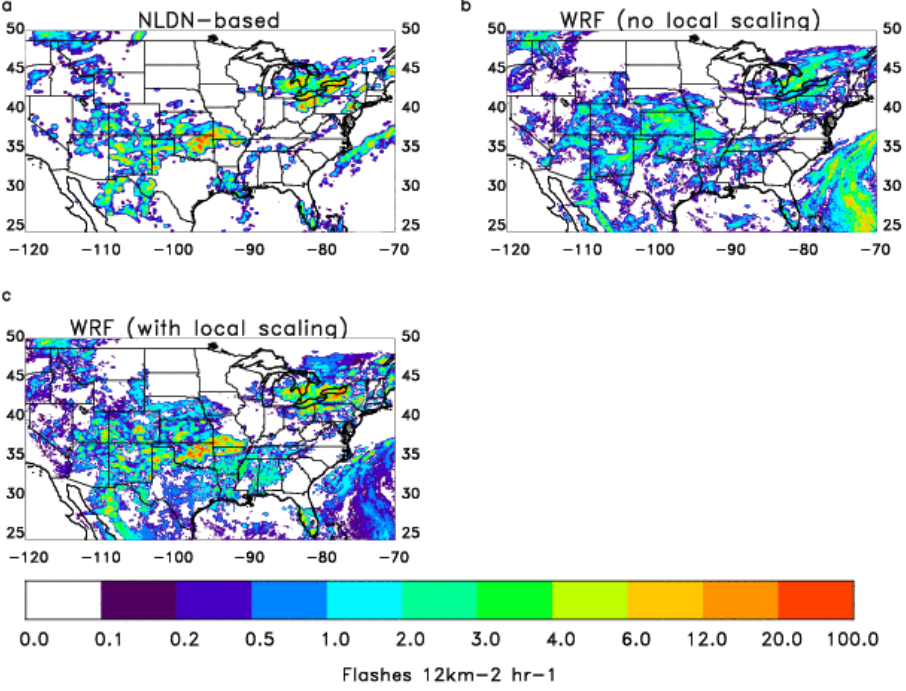
Fig. 2. Flash rate distribution on 10 July 2006. (a) NLDN-based estimate obtained by multiplying NLDN CG flash rate by Z +1, where Z is the smoothed climatological IC/CG ratio, (b) model flash rate before applying local-scaling factors, and (c) model flash rate after applying local-scaling factors